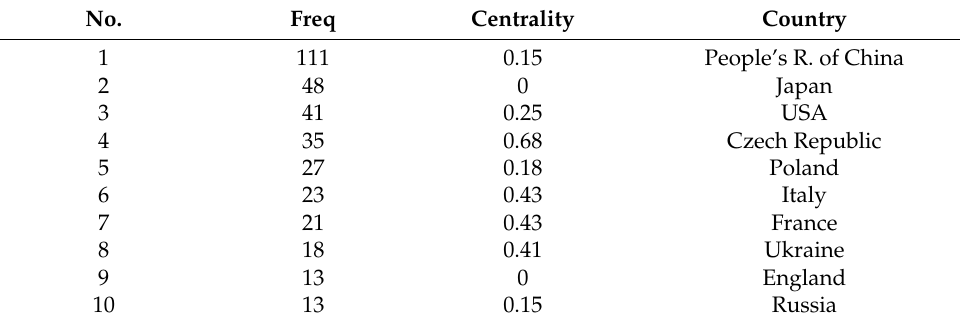
Figure 4. Visual map of macro cooperation network. Table 1. Top 10 countries with published